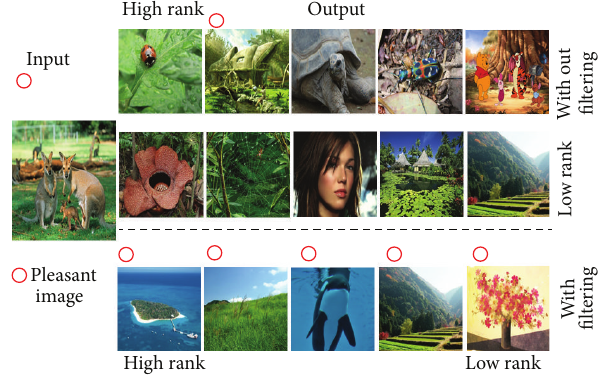
Figure 7: Output results, example 2.